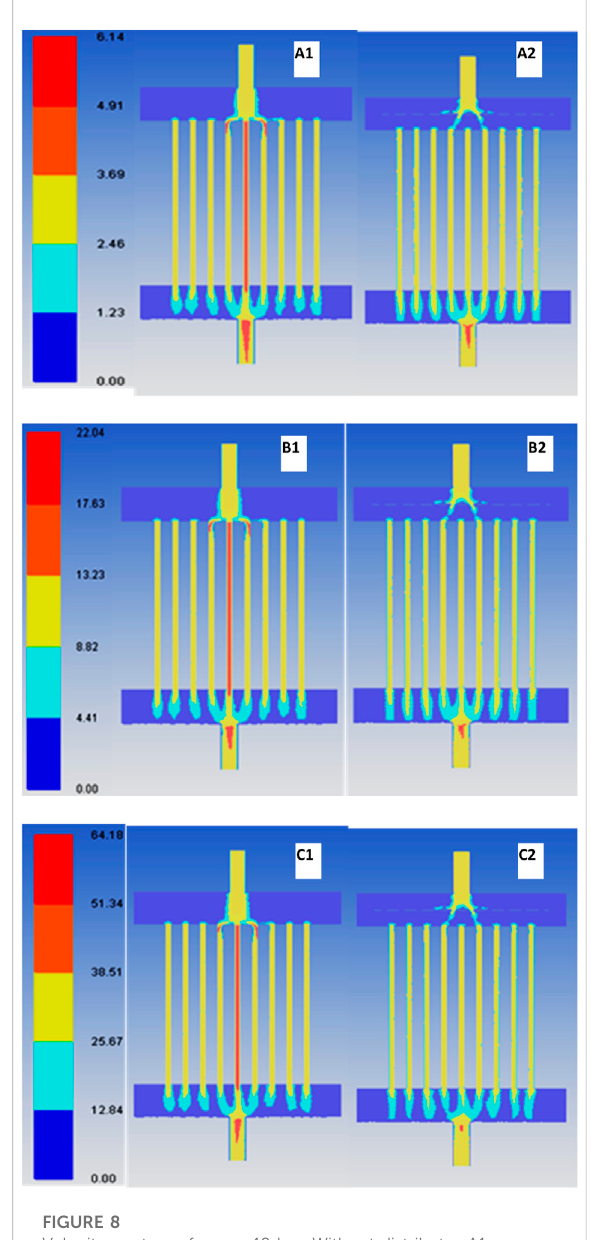
Velocity contours for p = 40 bar. Without distributor A1: Reynolds number (Re) = 2.82E+05; B1: Re = 9.86E+05; C1: Re = 2.82E+06. WithdistributorA2:Re=2.82E+05;B2:Re=9.86E+05; C2: Re = 2.82E+06 (all units of velocity are in given m/s for the color